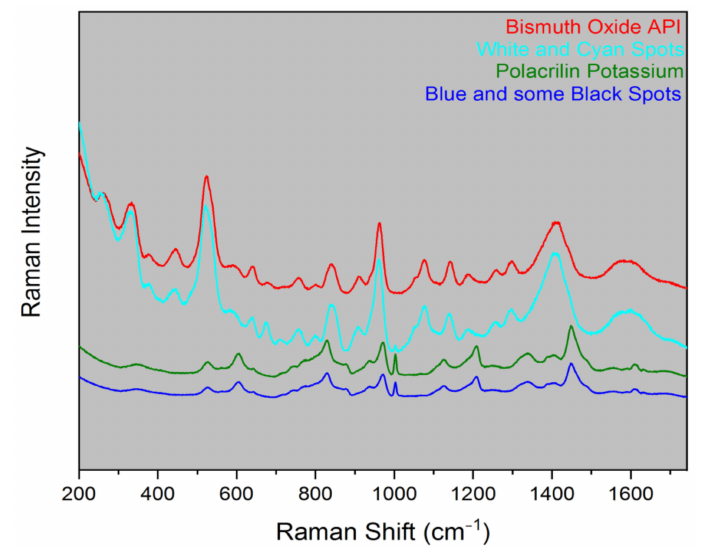
Figure 4. Images of the first and second random mapped area of Bismuth Oxide 120 mg FC Tabs after dispersion in original mode ( A , C ) and after processing with direct classical least squares (DCLS) method ( B , D ) using 50 × magnification objective lens.